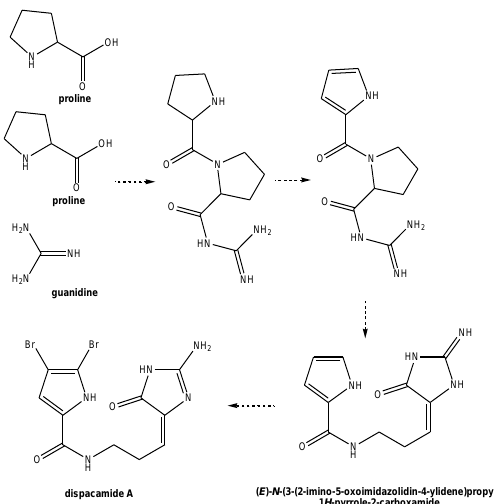
Figure 5. Sequential pyrrole and 2-aminoimida- zolinone sections formations (according to Travert and Al-Mourabit, 2004). Figure 6. Four building blocks and new